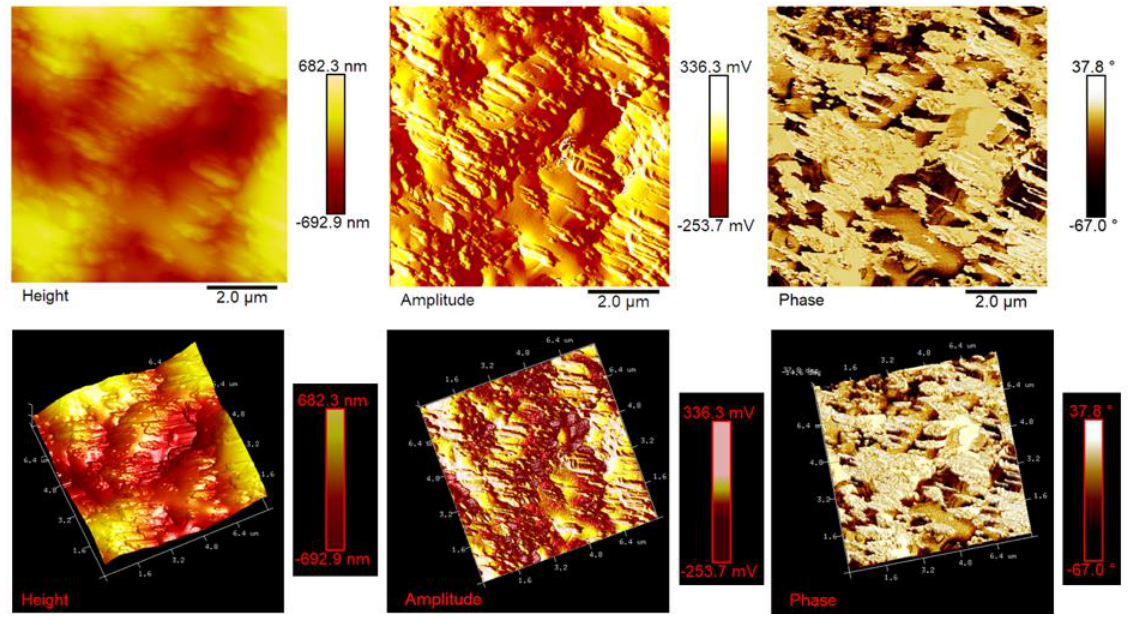
Figure 13. Tapping mode AFM micrographs of the fracture surface of the TBD + 0.64%MWCNTs sample (see on the top) and the corresponding 3D profiles (see on the bottom).